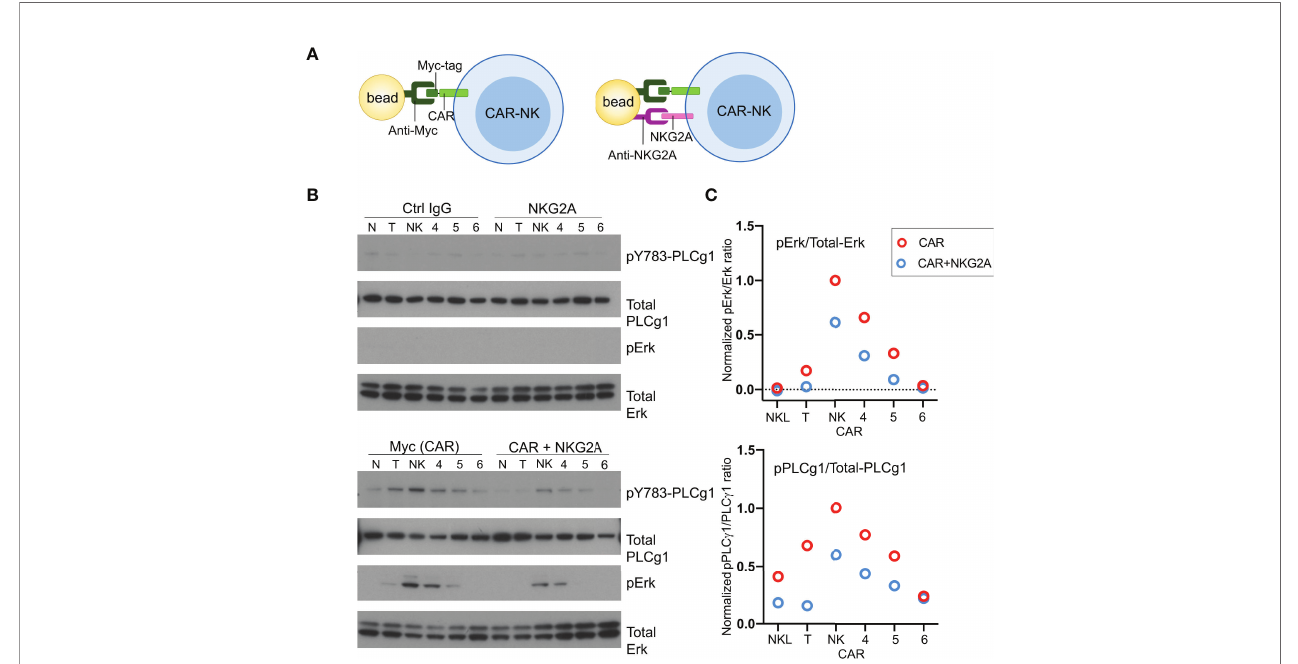
FIGURE 4 | CD19.NK-CAR overcomes NKG2A-mediated inhibition. (A) Diagram of CAR stimulation by antibodies immobilized on beads. (B) Western blot detecting activation signals in lysates of CARs-expressing NKL cells after stimulation by beads. Untransfected NKL cells (N) were included as control. The indicated antibodies were pre-bound to beads, and then incubated with CAR-NK cells for 10 min. Cell lysates were probed for the indicated signaling molecules. (C) Western blot quanti fi cation of the pErk/total-Erk and pPLC g 1/total-PLC g 1 ratios